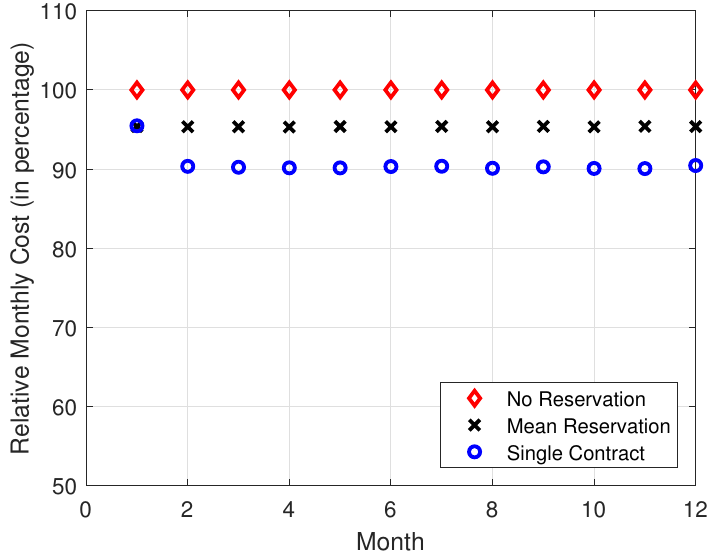
Figure 9. Relative monthly cost vs. month. The demand traffic is modeled as a Poisson stochastic process with mean = 4000 VMs. Monthly cost (in